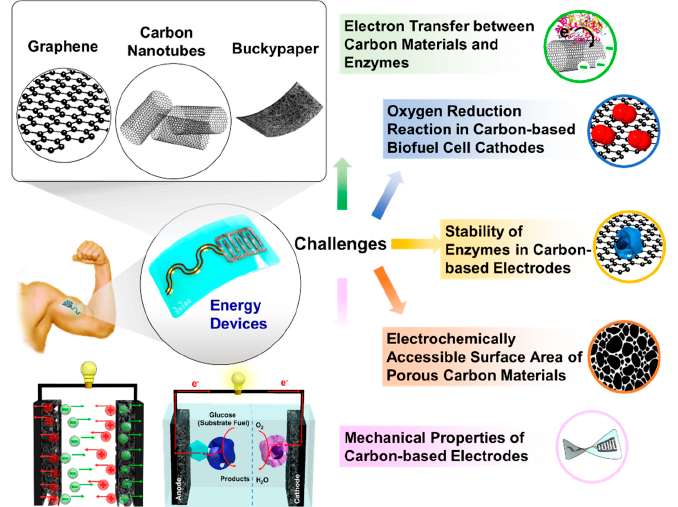
Figure 1. ( Left ) Illustration of the applications of carbon nanomaterials and composites for electrochemical energy devices. ( Right ) Examples of challenges in the development of carbon-based supercapacitors and BFCs toward personalized applications, such as wearable and implantable purposes.